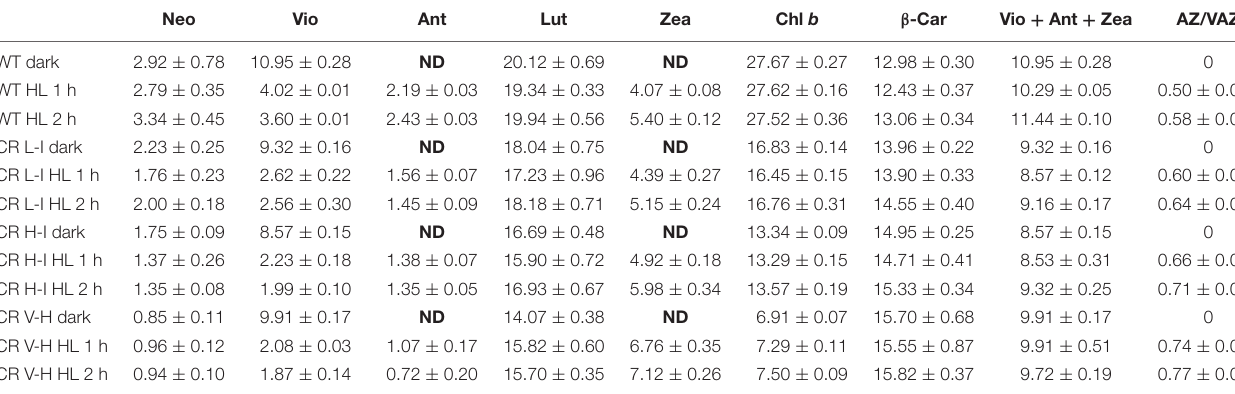
TABLE 1 | Comparison of pigment compositions in wild-type and CAO RNAi transgenic lines under darkness and high light stress. Neo Vio Ant Lut Zea Chl b β -Car Vio + Ant + Zea AZ/VAZ WT